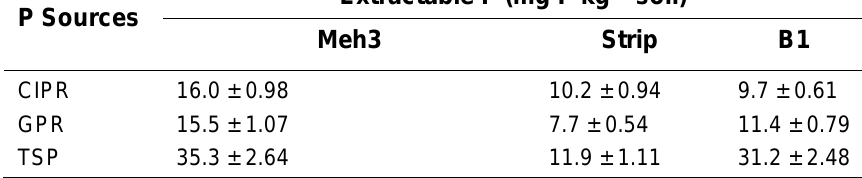
Amounts of P Extracted by the Three Soil